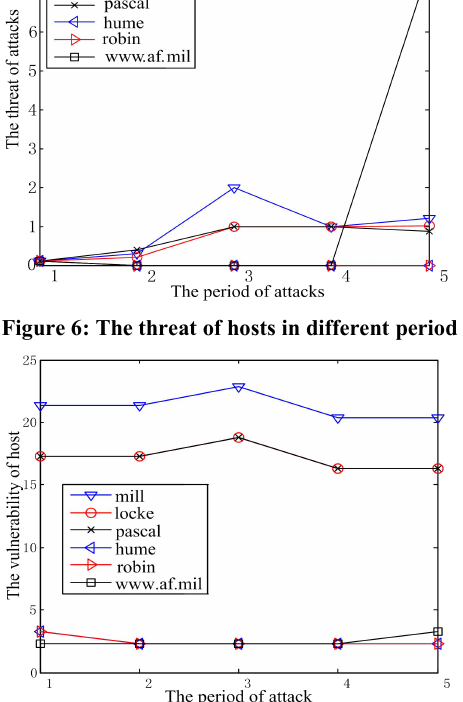
Figure 7: The vulnerability of hosts in different